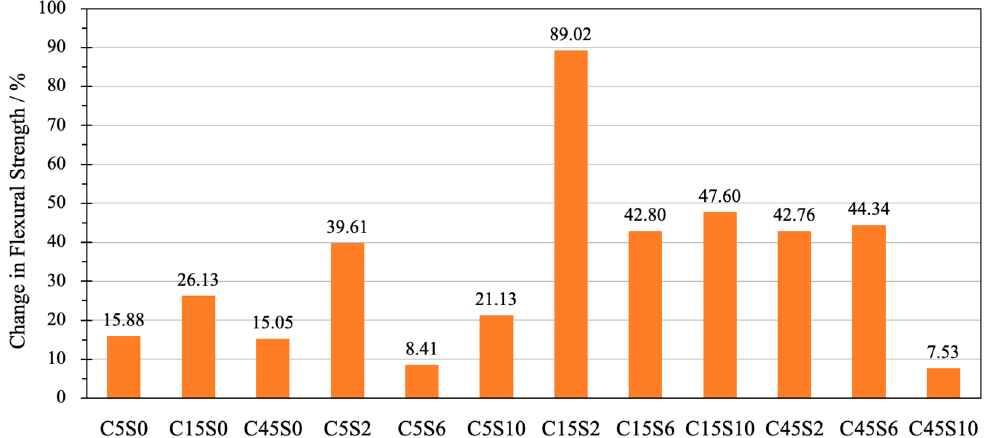
Figure 4. Change in flexural strength of LWCM.